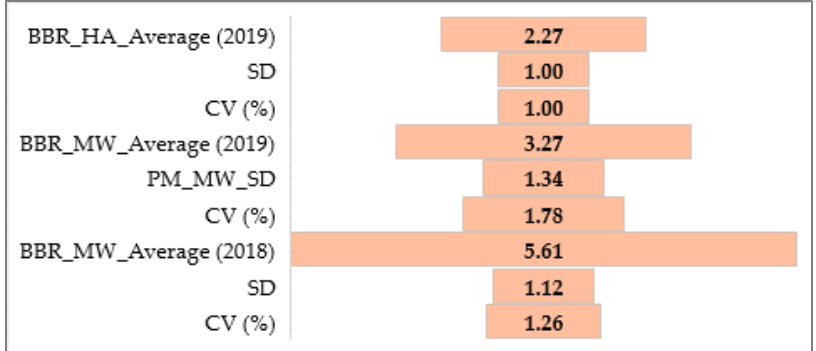
Figure 8. Summary data for barley brown rust severity on spring barley accessions phenotyped under field conditions during 2018–2019. Average values of disease severity, SD ( p ≤ 0.05) and CV (%) at the heading (BBR_HA) and the milky-waxy (BBR_MW) stages in 2019 and at the milky-waxy (BBR_MW) stage in 2018. Disease severity was scored on the 1–9 scale (1 = immune reaction).